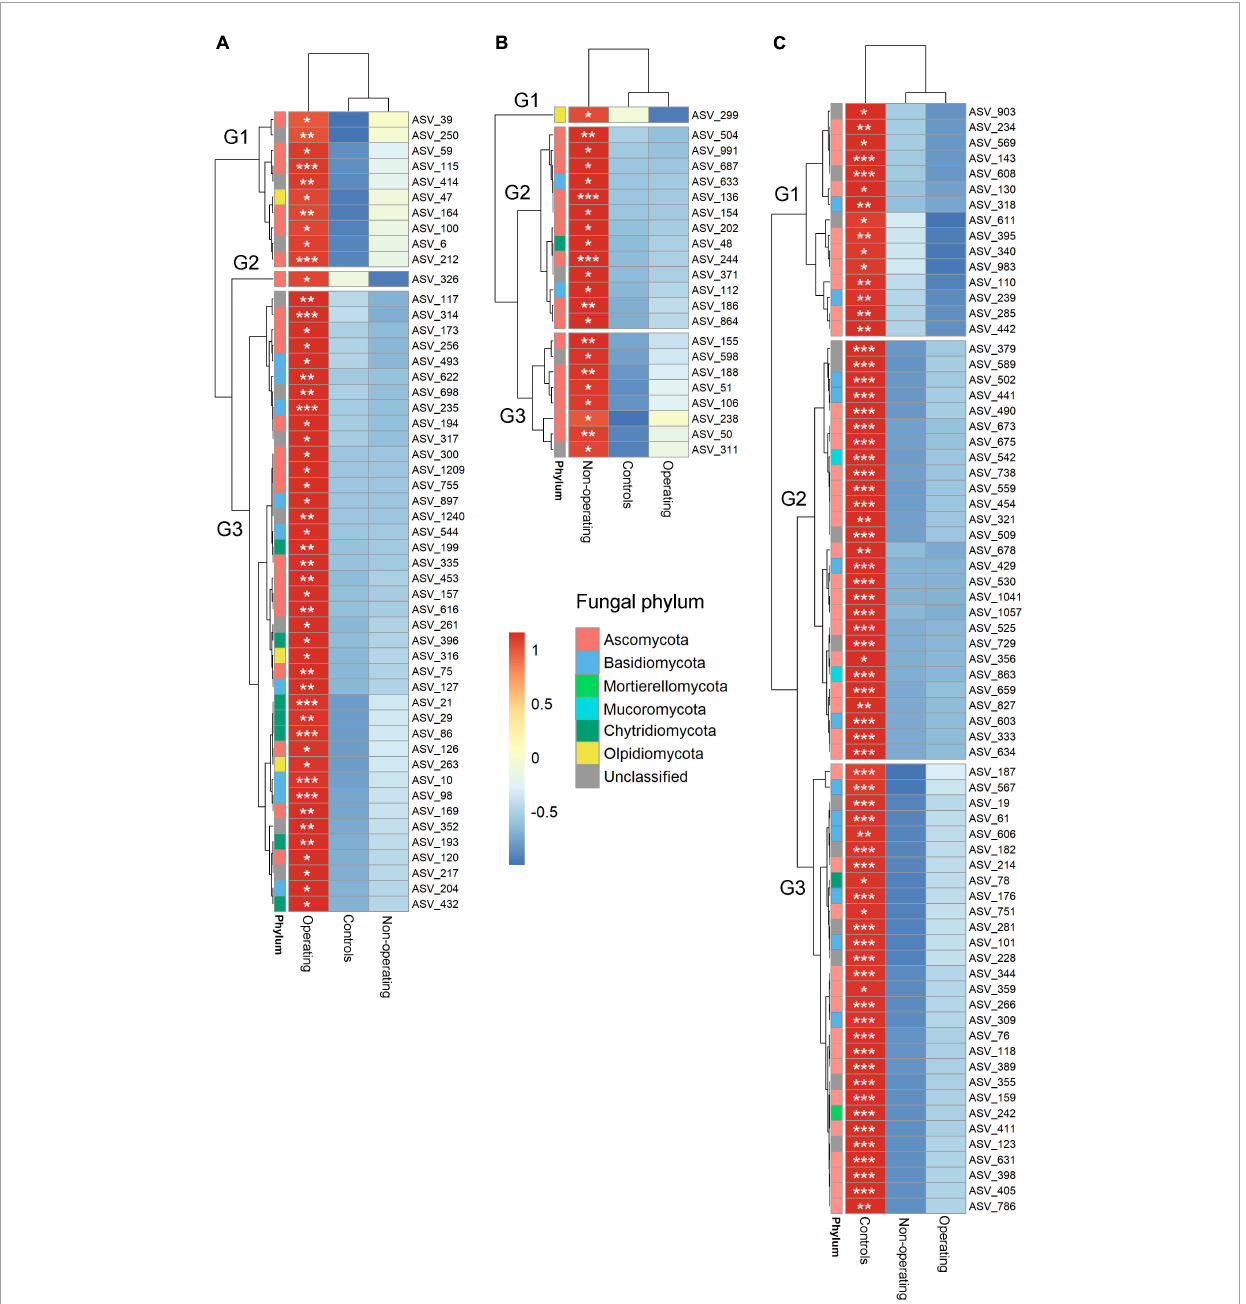
FIGURE5 Hierarchical clustering heatmaps of the relative abundance (scale by row) of fungal indicator ASVs for mining stages. (A) Indicators for operating mines; (B) indicators for non-operating sites; and (C) indicators for control sites. The color-coded scale indicates an increase (red) and a decrease (blue). Only ASVs with total relative abundance > 0.05% were included in the indicator analysis. * P < 0.05; ** P < 0.01; *** P < 0.001. Note relative abundance of each bacterial and fungal ASV is shown for each mine stage when not an indicator ASV in that stage.